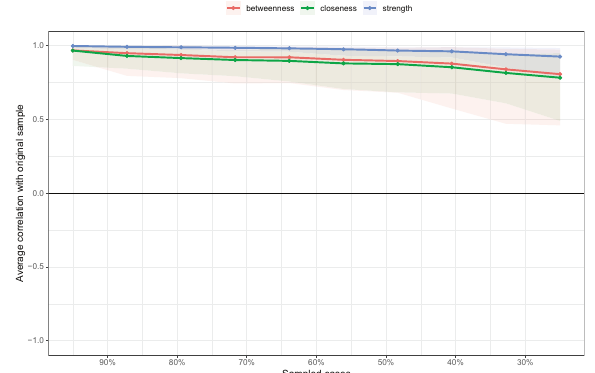
Fig. 3 Stability of centrality indices by case dropping subset bootstrap. The x -axis represents the percentage of cases of the original sample used at each step. The y -axis represents the average of correlations between the centrality indices from the original network and the centrality indices from the networks that were re-estimated after excluding increasing percentages of cases. Each line indicates the correlations among betweenness, closeness, and strength.